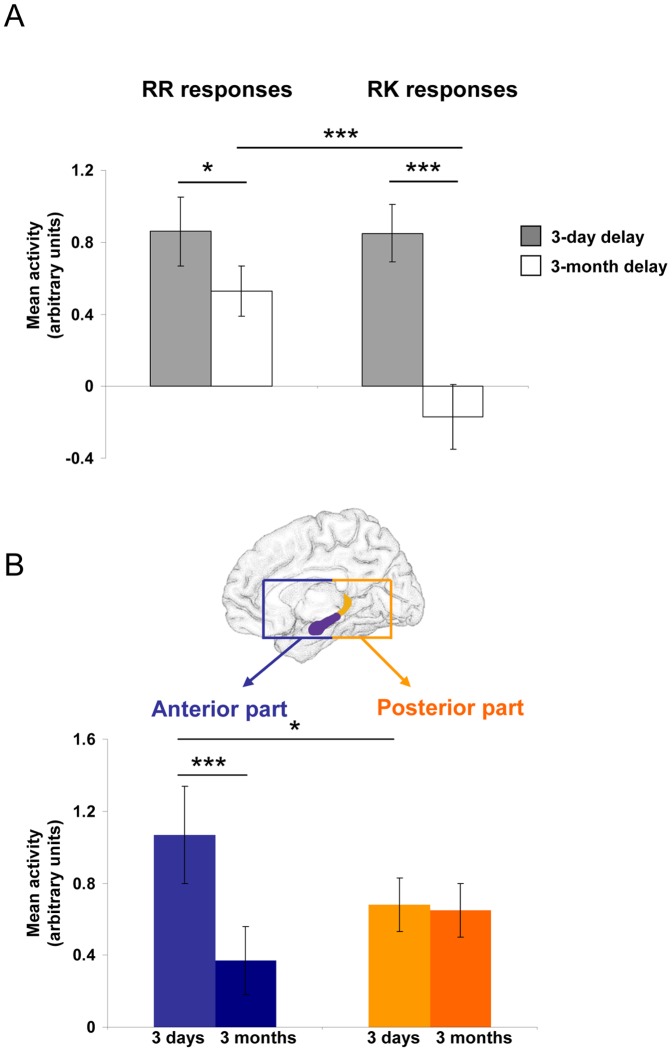
Results of ROI analyses in the hippocampus.A. Hippocampal activity (mean ± SEM) according to the nature of memories (RR vs RK responses) and delay (3 days vs 3 months). *: p<0.05, ***: p<0.001. B. Hippocampal activity (mean ± SEM) for RR responses according to the delay (3 days vs 3 months) distinguishing the anterior and posterior parts. ***: p<0.001.